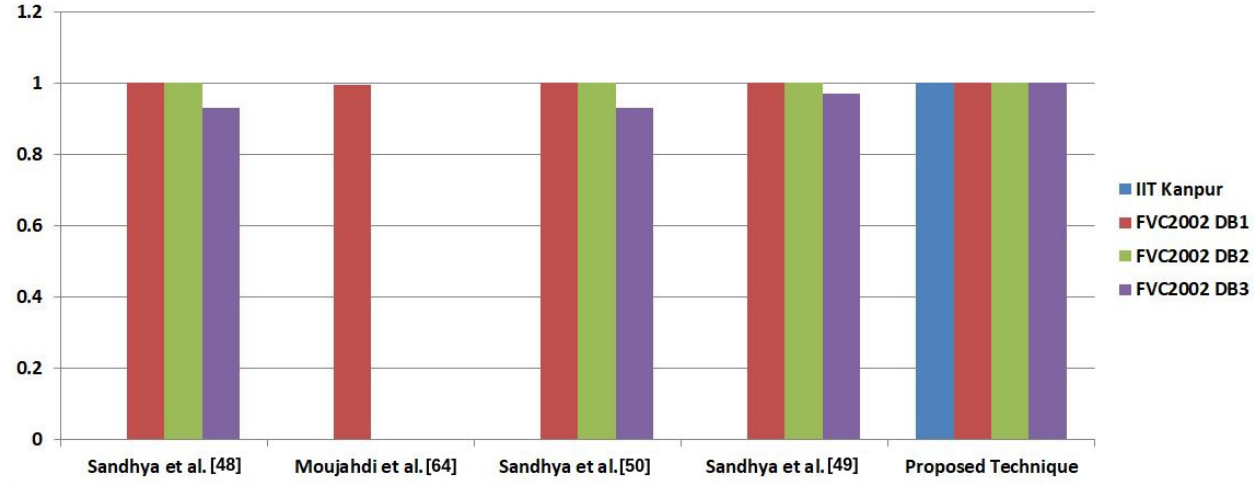
Table 5. As the KS test value ranges between 0 to 1, and the value closer to 1 means better separation between the genuine user and the imposter, so it can be observed that the proposed technique has good separation between the genuine and the imposter scores; as it technique for the KS test.